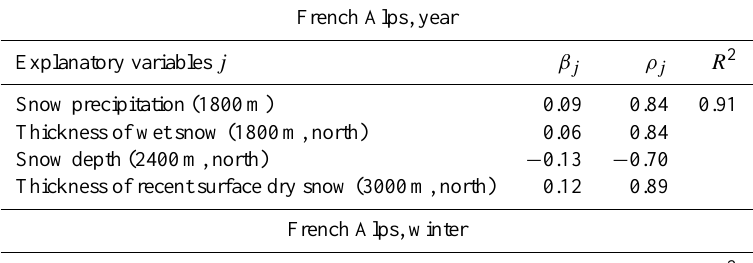
Table 1. Regression model characteristics for the French Alps (all year, winter and spring periods). For each model, the different variables are those selected by the stepwise regression. For each retained normalized explanatory variable, X norm coefficient in the model; ρ j the correlation coefficient between X norm the model.